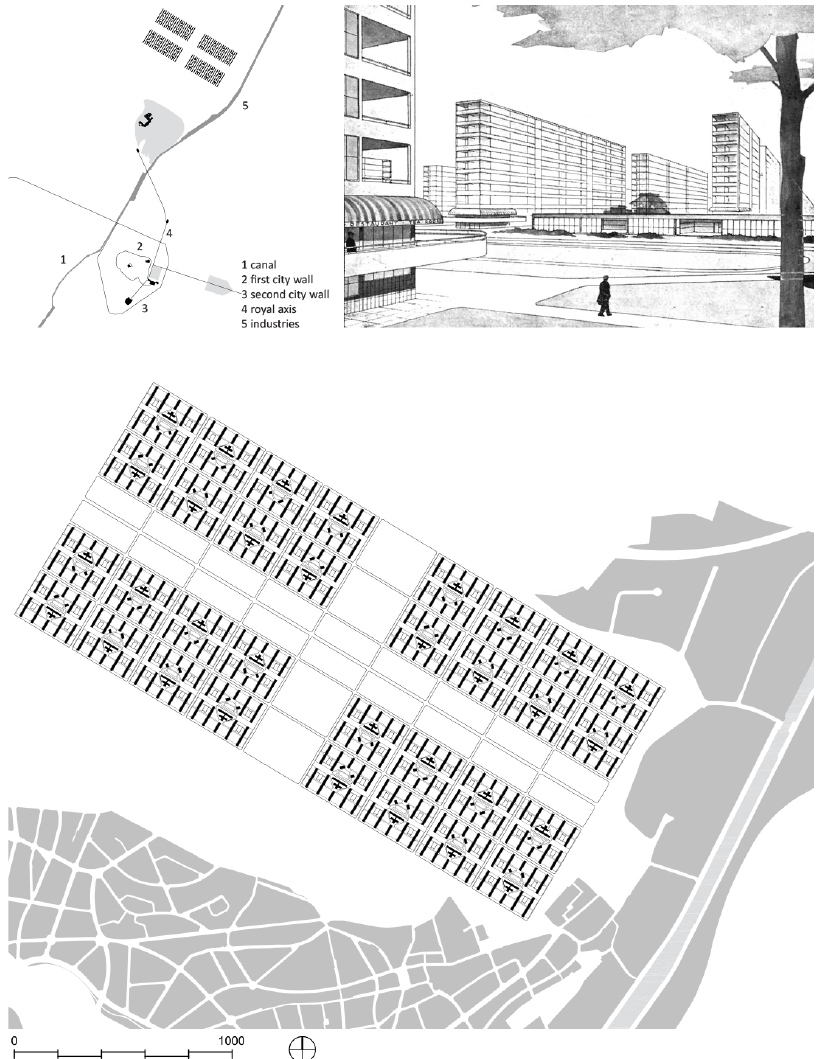
Figure 2. Bourgeois, Le Nouveau Bruxelles , 1930 (drawings by the author; perspective drawing by Bourgeois, 1931a, p. 412). tions in his description of Nouveau Bruxelles that “the work areas are generally set to the east of the canal, hence, our residential neighbourhood should be set to the west, to be protected from the smoke of factories” (Bourgeois, 1931a). The factories’ location is also visi- ble in a perspective drawing complementing the urban scheme of Nouveau Bruxelles ( Bourgeois , 1931a, p.